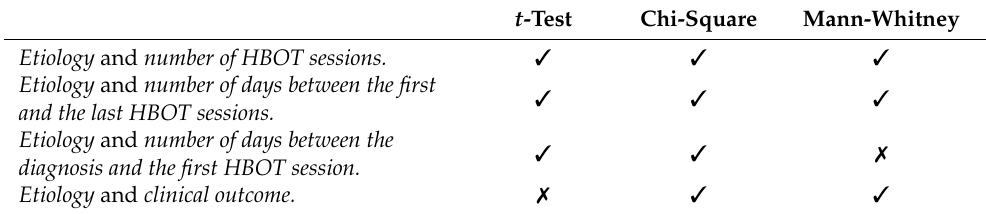
Table 5. Parametric t -tests for independent samples and non-parametric tests. t -Test Chi-Square Mann-Whitney Etiology and number of HBOT sessions.